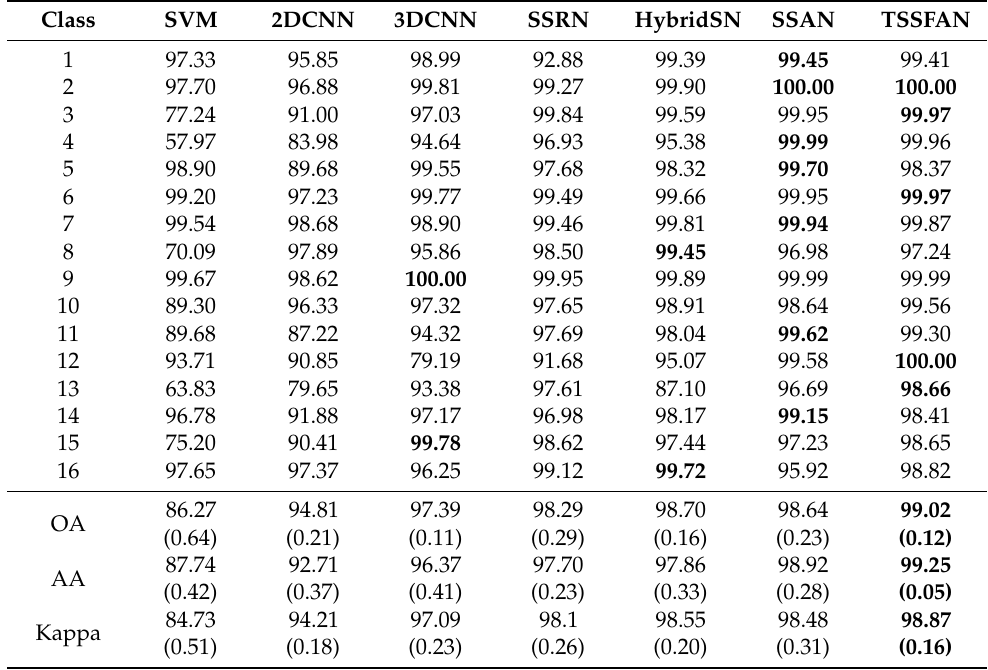
Table 7. Classification results of each method in Salinas Scene (The bold format represents the best result).